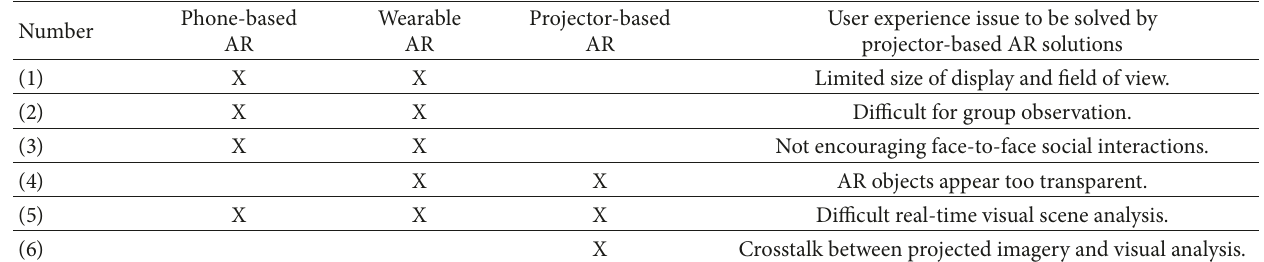
Table 1: Six issues regarding mobile-based AR user experiences to be discussed in this paper. Projector-based User experience issue to be solved by projector-based AR solutions Limited size of display and field of view. Difficult for group observation. Not encouraging face-to-face social interactions. AR objects appear too transparent. Difficult real-time visual scene analysis. X Crosstalk between projected imagery and visual